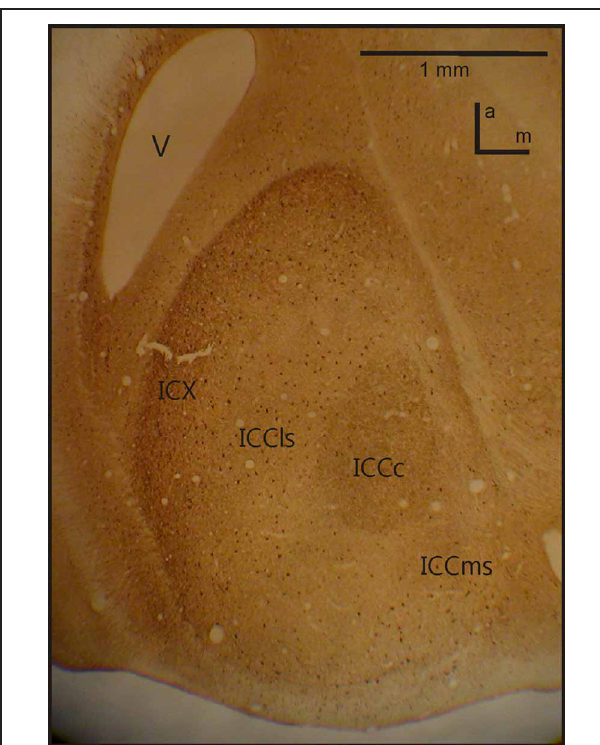
FIGURE 3 | ITD tuning. Shown are examples of the variations of the normalized responses with ITD of neurons located in different sub-nuclei of the IC. The stimulus for collecting these tuning curves was broadband noise. ITD tuning is periodic in the ICCc with the distance of the peaks reflecting the best frequency of the neuron (A) . All peaks have a similar height. A similar tuning is observed in the cells of the ICCls (B) . By contrast in the responses of the cells of the ICX one peak, the main peak, is clearly dominant compared to the other peaks, the side peaks (C)